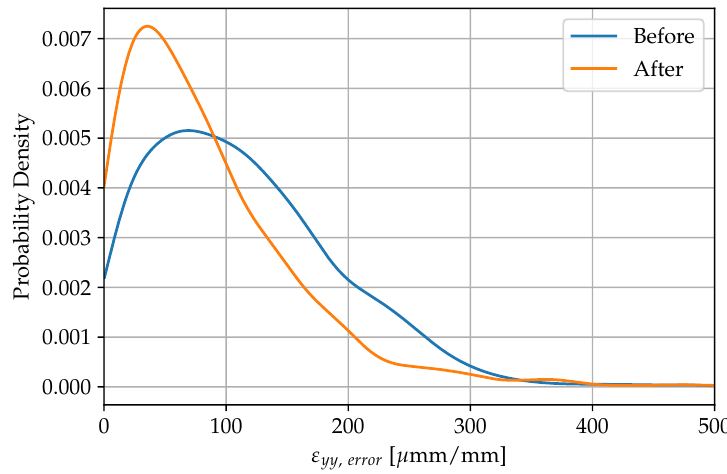
Figure 16. A histogram showing the change in the probability density of the error from the application of the error compensation method. This data is also for the 700th image of Test 3.